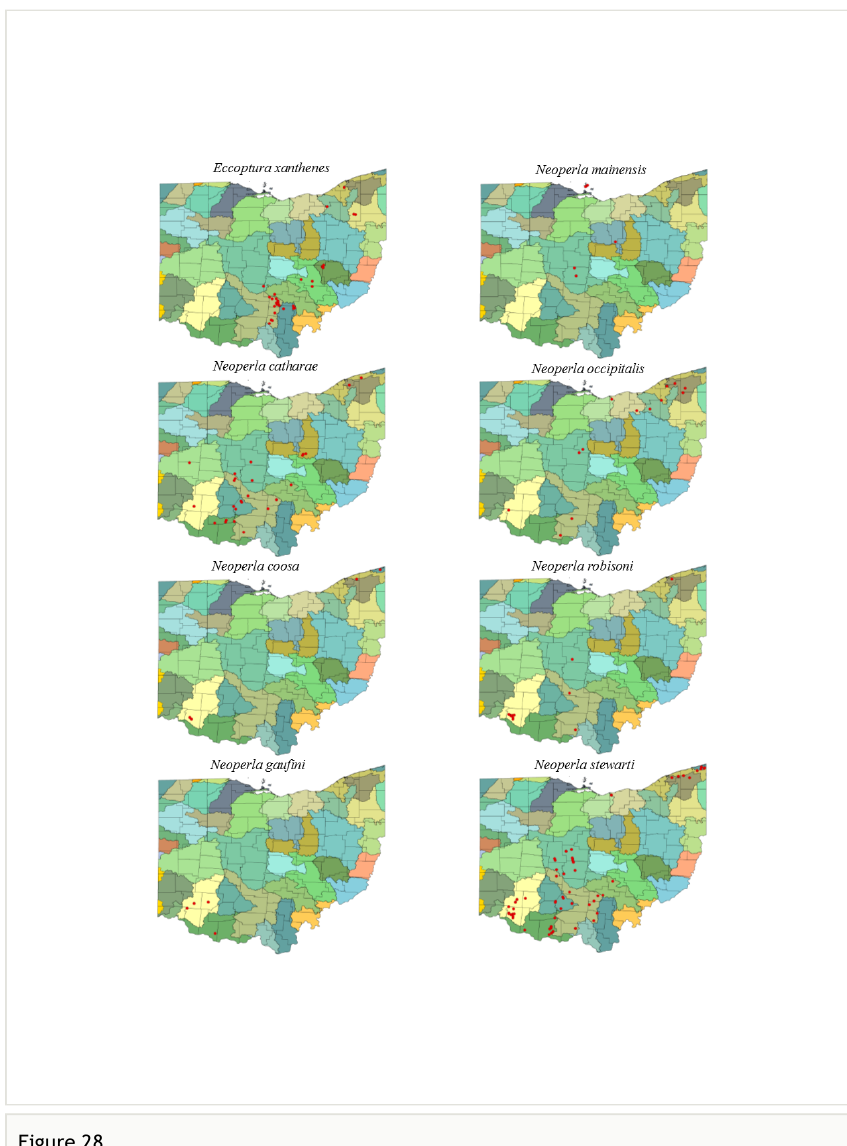
Figure 28. Distribution of Perlidae in